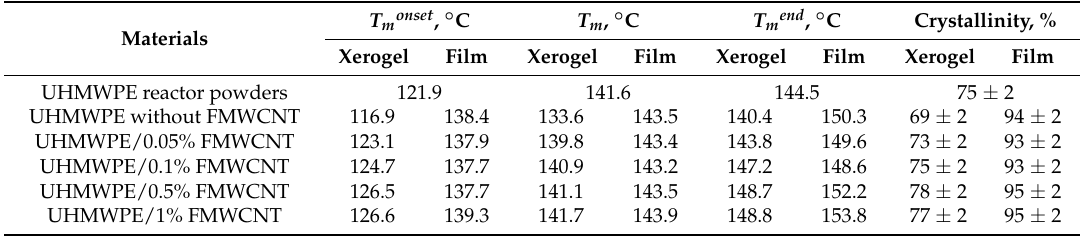
Table 1. DSC data of xerogels and films based on UHMWPE and UHMWPE/FMWCNT with a DR of